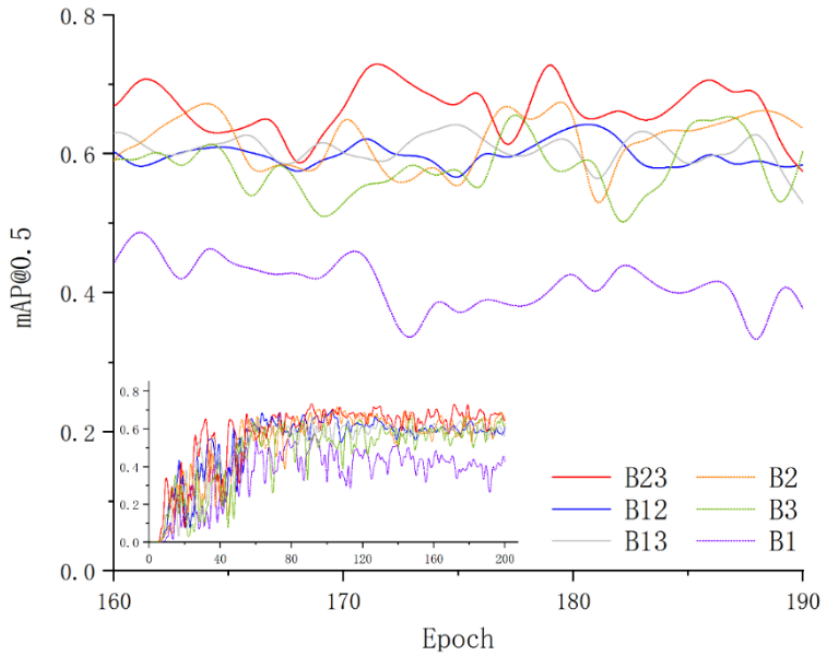
Figure 9. The mAP@0.5 of combined bands B23, B12, B13, and single band B1, B2, B3 in 200 epochs.